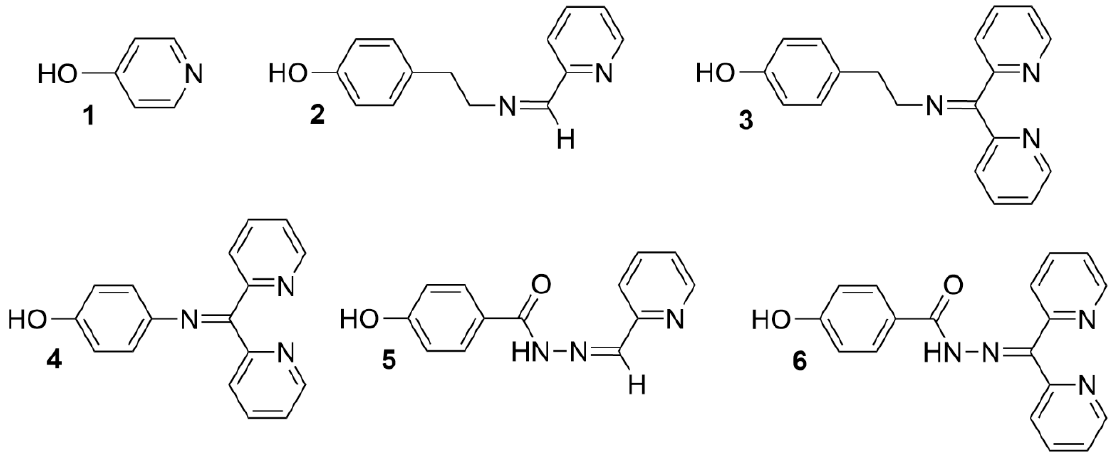
Figure 2. N-, N,N- and N,N,N-ligands functionalized by a